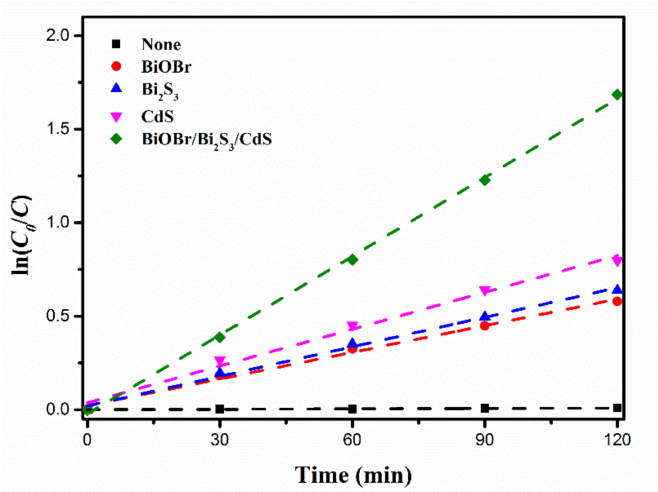
Figure 6. The pseudo-first-order kinetics degradation of MeB in the presence of different